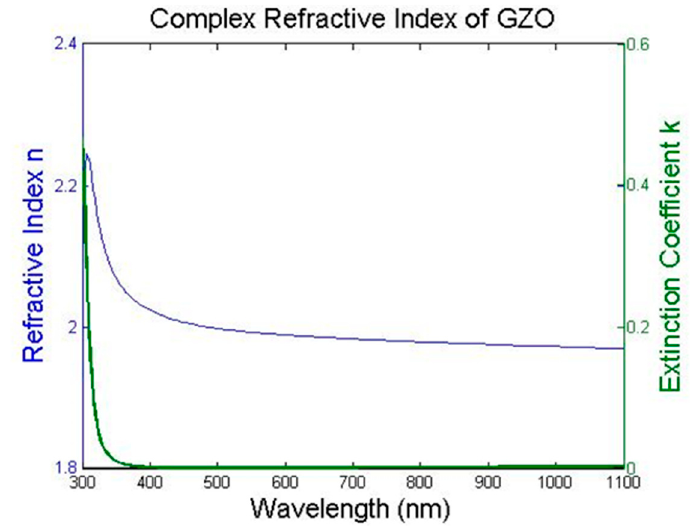
Figure 5. Simulation of the refractive index and extinction coefficient of GZO thin film.